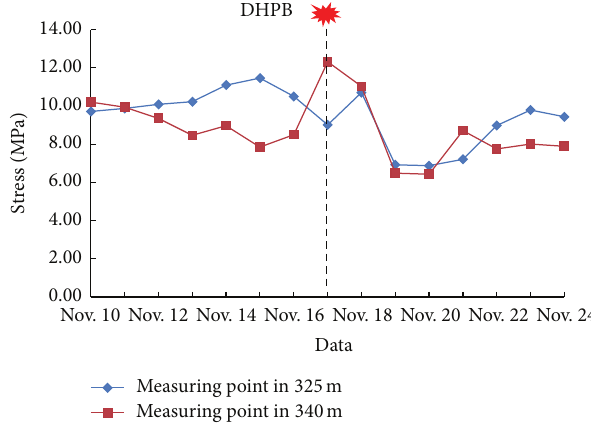
Figure 6: Borehole stresses variation before and after the blasting.